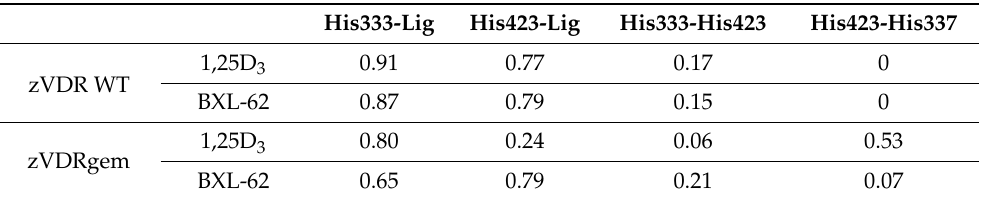
Table 1. Distance probabilities in zVDR and zVDRgem complexes. The distance criteria used implies that at least one heavy atom from each side chain lies within 3.5 Å of distance. His333-Lig His423-Lig